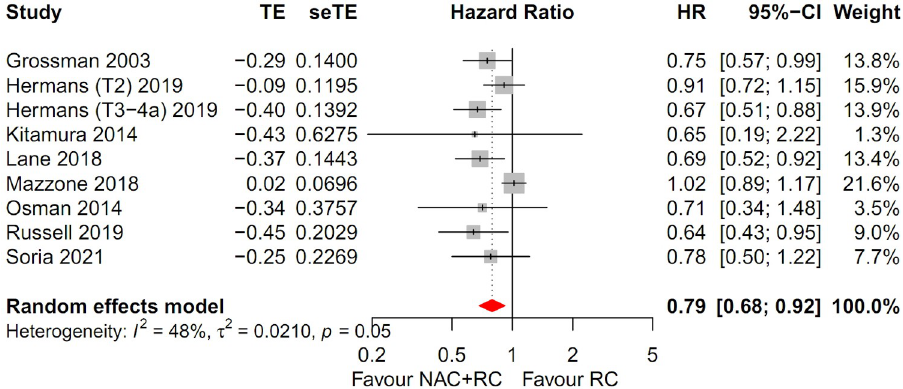
(Fig 3A). We conducted sensitivity analysis for outcome reporting bias (ORB) to examine the degree of heterogeneity (Fig 4A). The sensitivity of this meta-analysis was considered robust, as the results on OS were not affected until up to two studies were excluded.